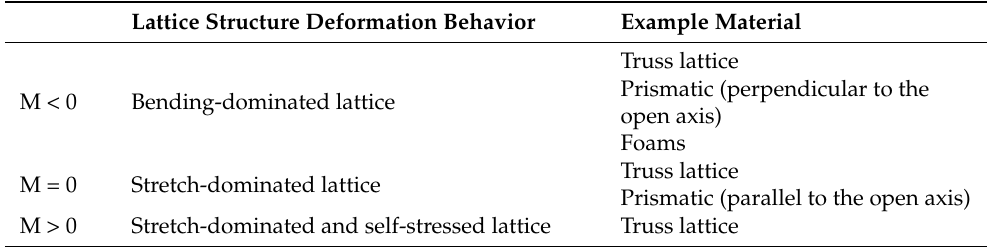
Table 2 . Classification of lattice deformation behavior by Maxwell’s criterion value .